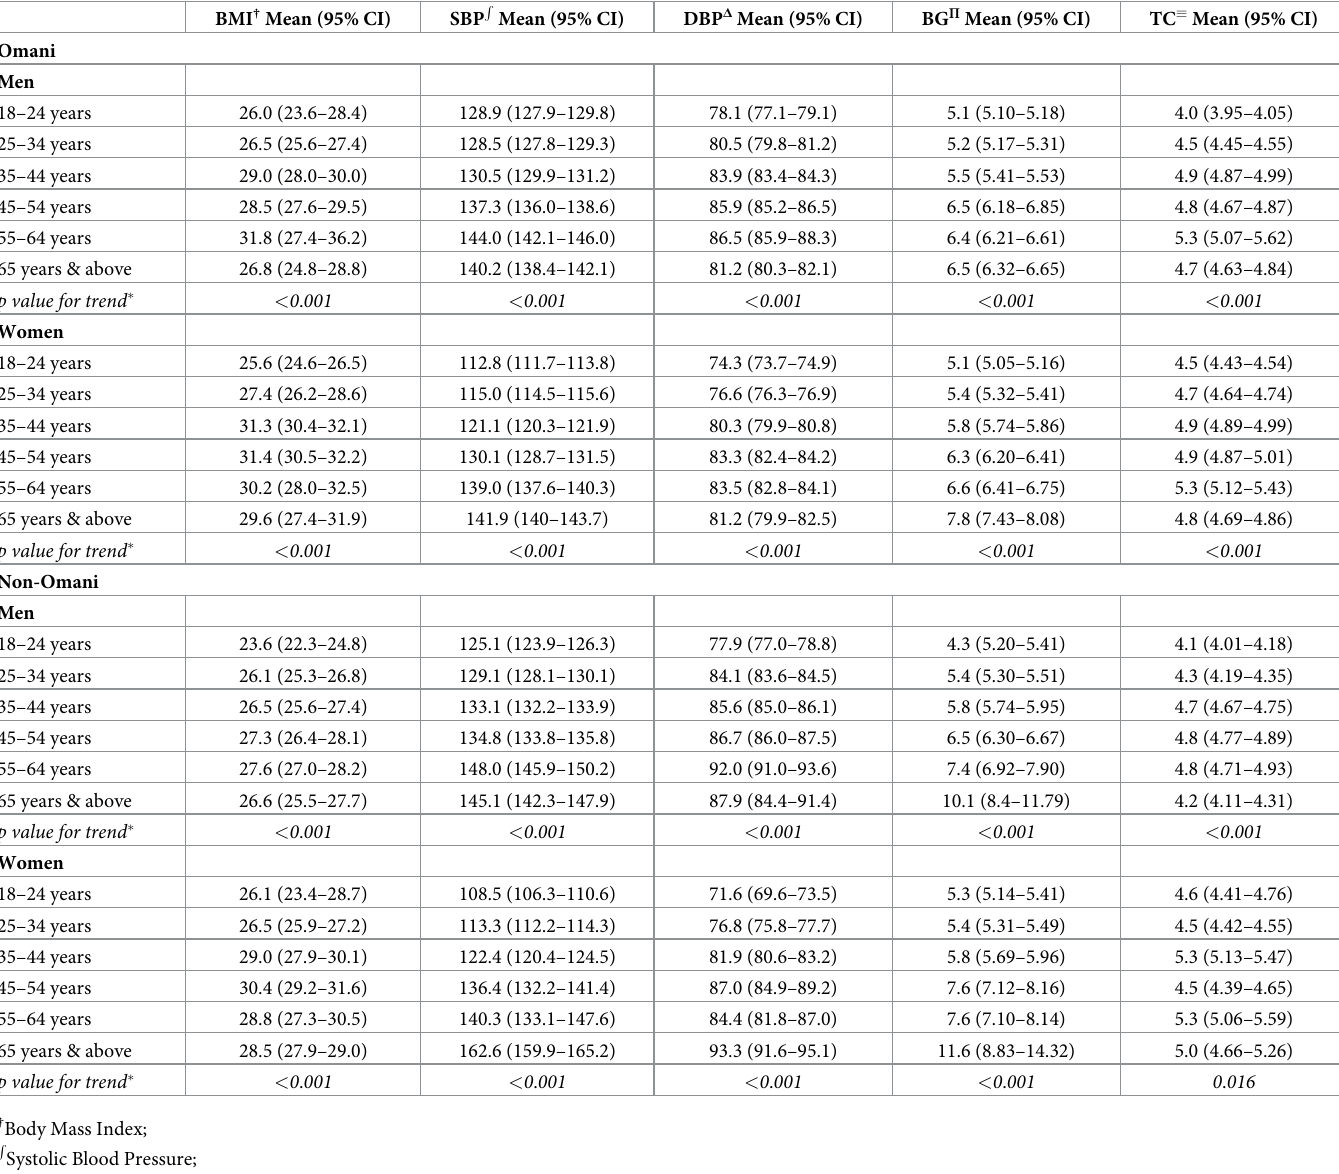
Table 4. Risk factor estimates of non-communicable diseases by nationality, sex, and age